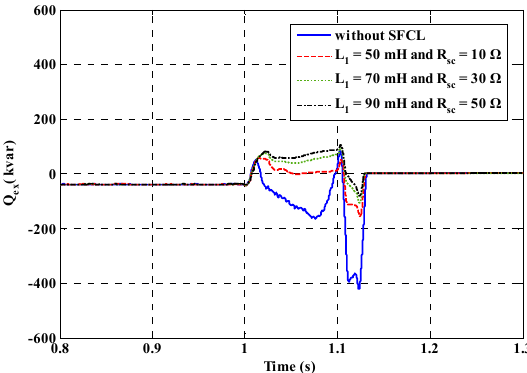
Figure 12. Reactive power of the micro ‐ grid at the PCC under the external fault.